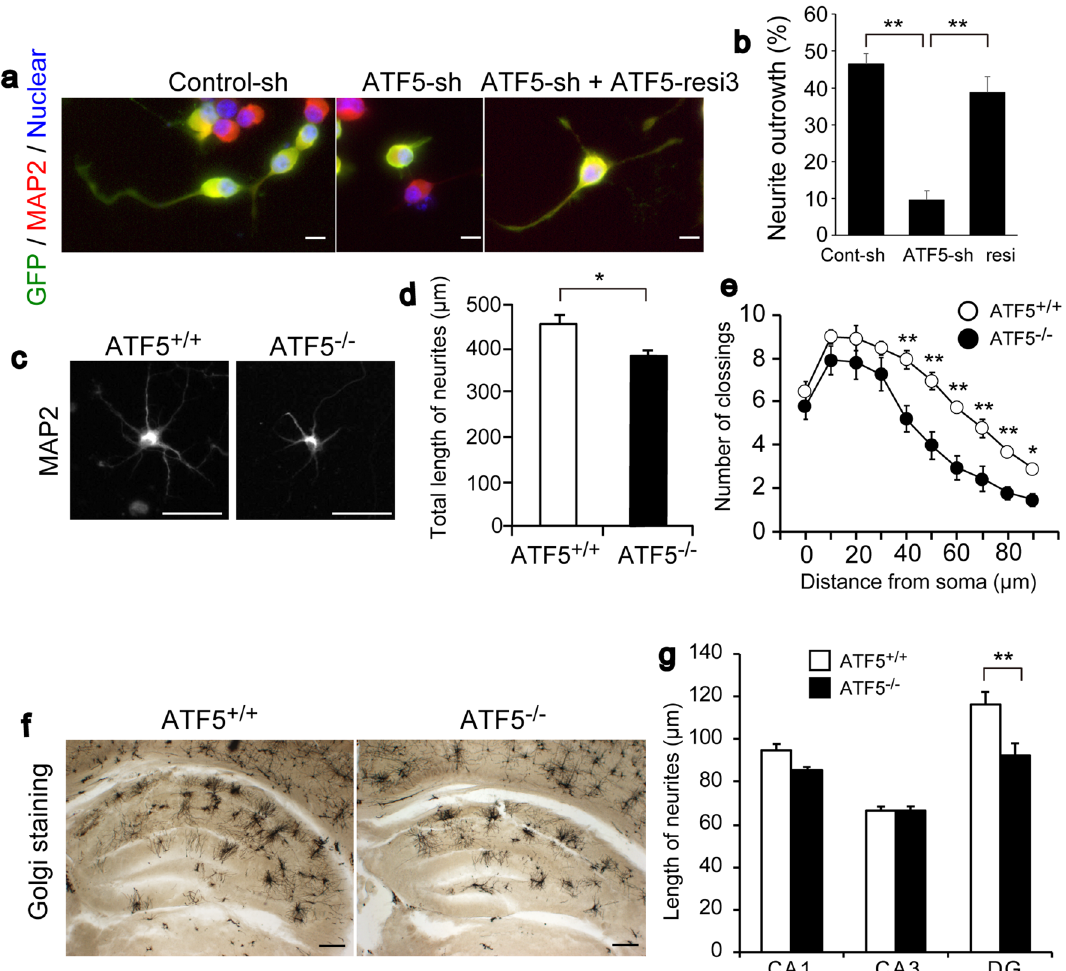
Figure 7. ATF5 deficiency affected dendritic outgrowth in vivo and in vitro. ( a , b ) Immunostaining for GFP and the dendritic marker MAP2 in Neuro-2a cells transfected with ATF5-sh or Control-sh with or without ATF5- resi. A GFP expression vector was introduced into Neuro-2a cells. After 1 day of transfection, the medium was replaced with serum-free medium to induce the differentiation of Neuro-2a cells. After 3 days, the Neuro-2a cells were fixed and immunostained. ( b ) Quantification of the percentage of neurite outgrowth in GFP / MAP2 double-positive cells. The rate of neurite outgrowth was determined by the population of neurons with neurites longer than the cell body diameter. ( c ) Immunostaining for MAP2 in hippocampal primary cells isolated from mice on E17 and cultured for 7 days. ( d ) Quantification of the total lengths of neurites. ( e ) Sholl analysis of the MAP2-stained dendrite from the hippocampal primary cells. ( f , g ) Golgi-Cox staining for hippocampal neurons in adult mice. ( g ) Quantification of the lengths of the longest dendrites in each hippocampal region. Data are presented as mean ± S.E.M. ( n = 3 independent experiments ( b ), n = 4 independent cell culture experiments per mice group ( d , e ), n = 4 mice per group (CA1 and DG in ( g )) and n = 6 mice per group (CA3 in ( g )), * p < 0.05, ** p < 0.01; one-way ANOVA followed by Tukey–Kramer test ( b ), Student’s t-test ( d ), two-way ANOVA followed by Tukey–Kramer test ( e , g )). Scale bars represent 10 µm in ( a ), 50 µm in ( c ), and 200 µm in ( f